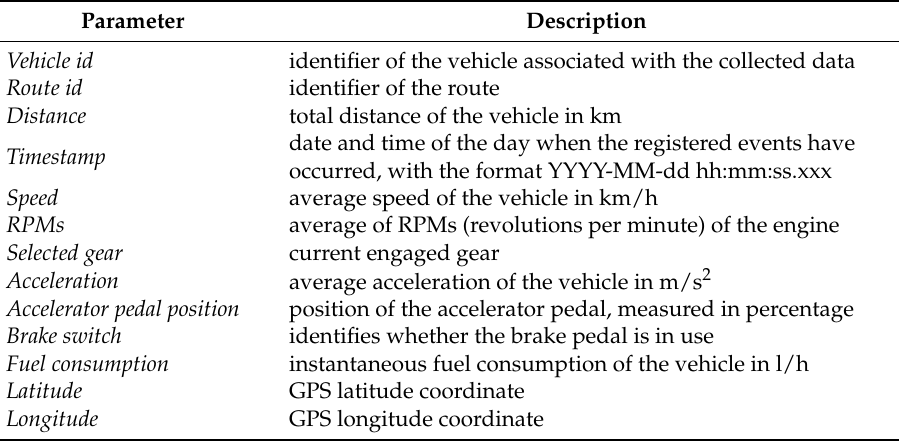
Table 1. Description of the traces collected from the vehicle under test.